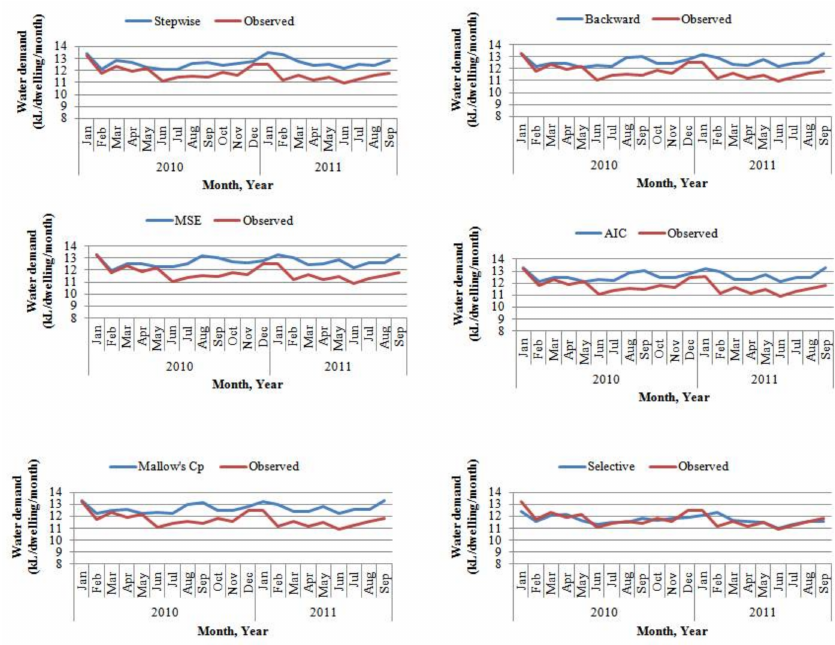
Figure 5. Comparison of modelled results of all the developed models (i.e., stepwise, forward, backward, MSE, Mallow’s C p , AIC and selective variable regression (Model